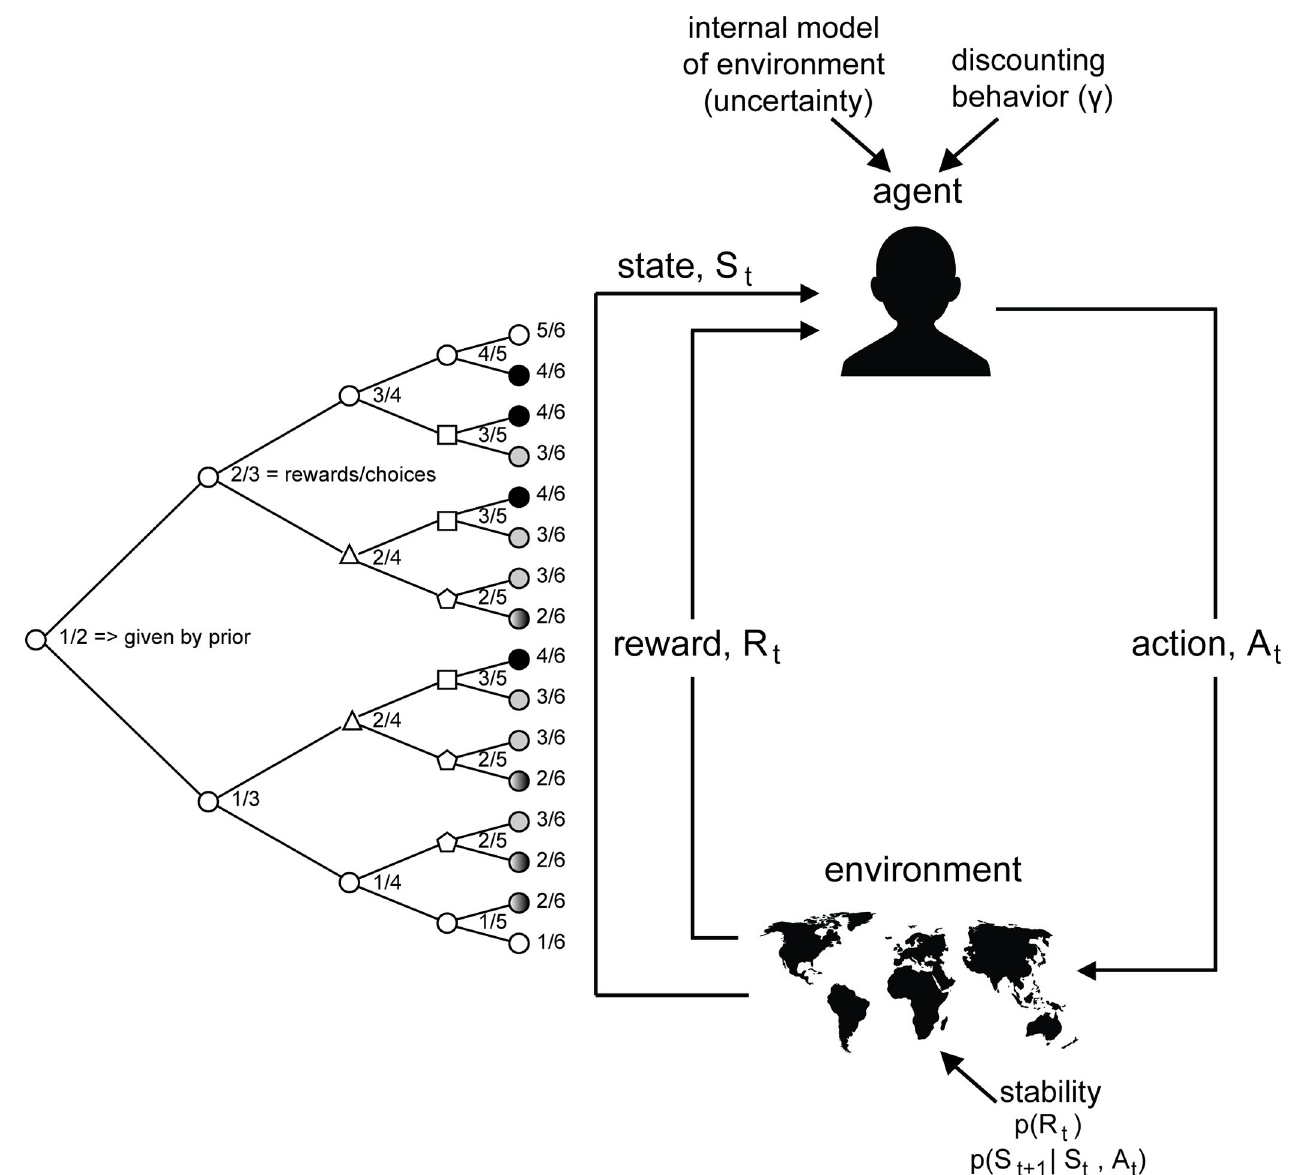
Fig 1. Agent and Environment Interactions in Reinforcement Learning (RL), Markov Decision Process (MDP) framework. A schematic of how an agent interacts with the environment and learns to maximize rewards in a MDP framework. An agent selects actions, A t , which lead to changes in state, S t and rewards, R t , where t indicates the trial or time point. The agent’s internal model of the environment and weighting of future rewards, or discount factor, γ , affect the actions taken. The stability of the environment is captured by transition probabilities to future states p (S t+1 |S t , A t ) as well as the probability of receiving reward p (R t ); these also affect reward outcomes. An example reward distribution tree for a binomial bandit is shown on the left for a bandit option in a choice task. As an agent selects the option that gives a probabilistic reward, it traverses the tree based on outcomes. Each node in the tree represents a choice point where that option was chosen. The node shape and shading indicate whether a node represents a unique state. Circle nodes are unique. Other shapes or shading of nodes indicate duplicate states that have multiple choice paths to them. While MDPs are independent of time and history, these factors often affect decision-making behavior. Each upper branch in the state space tree represents a rewarded choice, and each lower branch represents an unrewarded choice. Thus, the number at each node indicates the posterior over the number of rewards and the number of times the option has been chosen. Traversal through this tree leads to the accumulation of evidence for whether an option is highly rewarding or not rewarding, which in turn affects the agent’s future actions. Image credit: Wikimedia commons (bust image); Openclipart.org (map image).